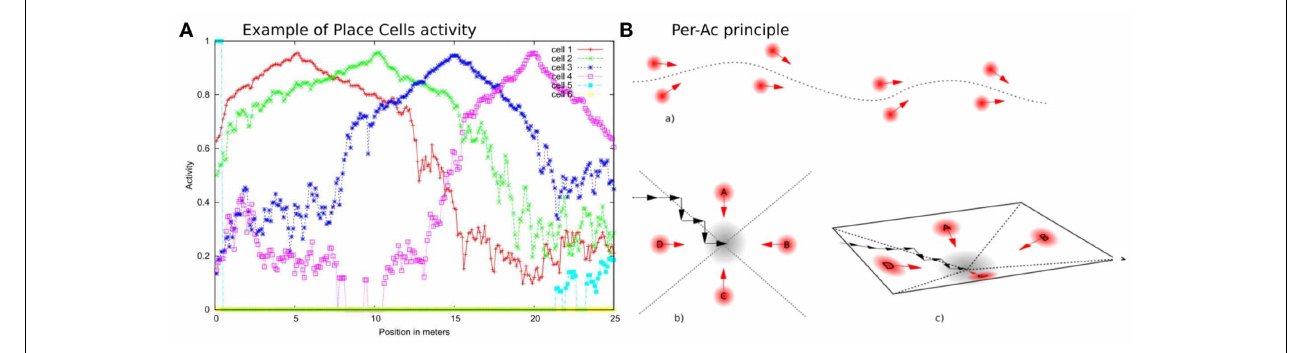
(B) PerAc principle: Only a few Place/Action associations are needed to perform simple and robust behaviors such as Path learning (a) or